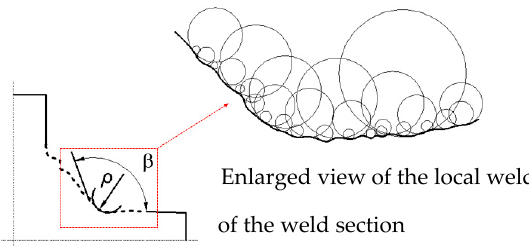
Figure 3. Local detail of the weld toe of the weld section.